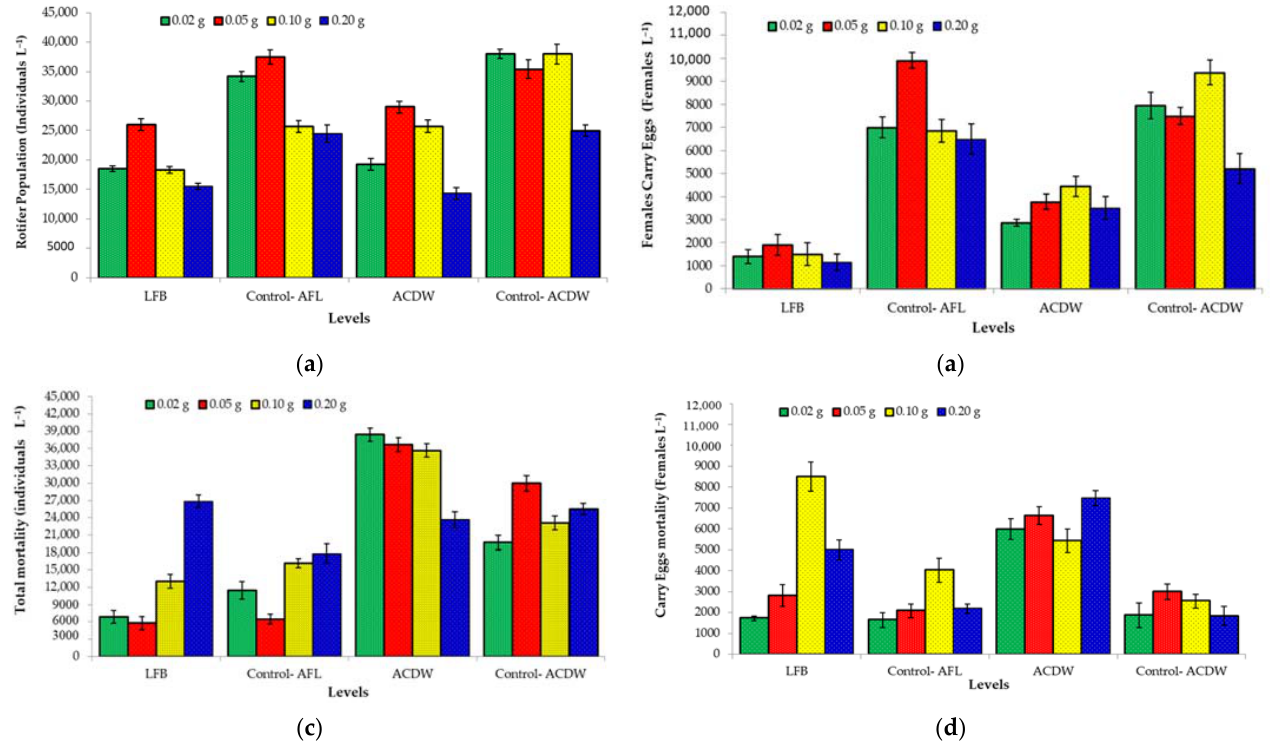
Figure 13. Effect of several levels of cyanobacterial strain Arthrospira platensis NIOF17/003 (LFB and ACDW) saturated with ammonium ions removed from aquaculture wastewater, compared to the same traditional levels of A. platensis as control (LFB ‐ Control and ACDW ‐ Control) on the Brachionus plicatilis population, the population of females carrying eggs, total rotifer mortality, and mortality of the females carrying eggs (( a – d ), respectively).